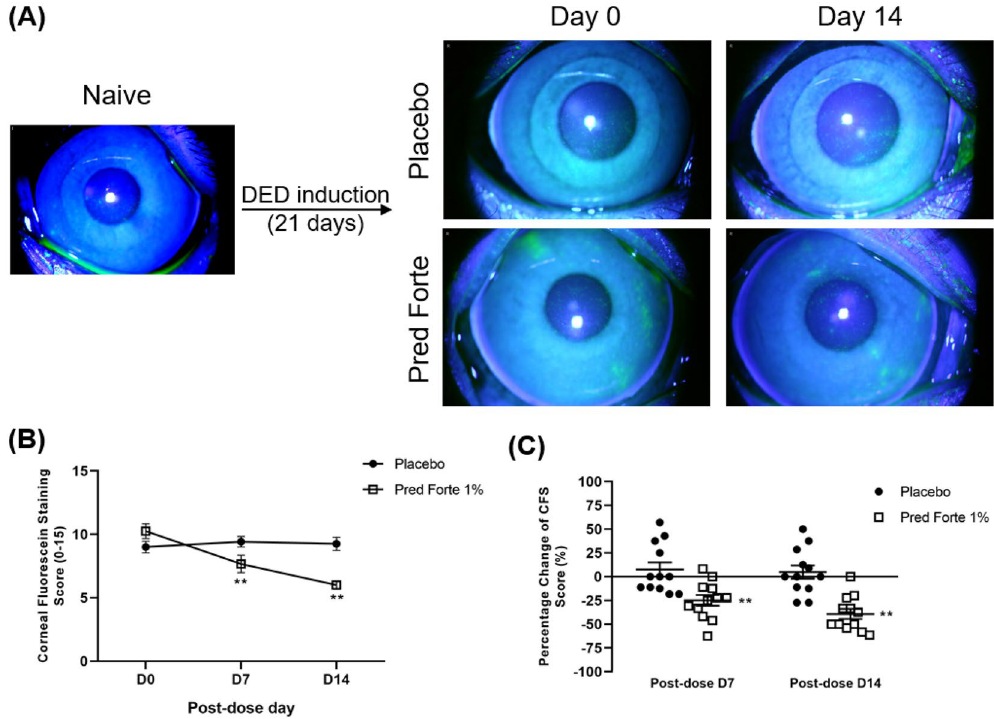
Figure 4. Corneal fluorescein staining following topical corticosteroid treatment. Rhesus monkeys were housed in a controlled environment room for 21 days to induce evaporative dry eye. From day 21 post-dry eye induction (Day 0 of treatment), both corneas were topically treated with two drops of Pred Forte 1% or normal saline (placebo) thrice daily for 14 days. ( A ) Representative corneal fluorescein staining images of Pred Forte 1% and placebo-treated monkeys on day of treatment initiation (Day 0), which serves as the baseline, and day 14 post-treatment induction. ( B ) Line graph showing CFS scores on days 0, 7, and 14 post-treatment induction. ( C ) Dot plot depicting percent change in CFS score from baseline (pre-treatment) on day 7 and 14 post-treatment induction. Each dot represents a single reading from a monkey. Representative data from two independent experiments are shown, each treatment group consisted of n = 6 eyes/group. Data are represented as mean ± SEM (error bar). T-test; ** p < 0.01.